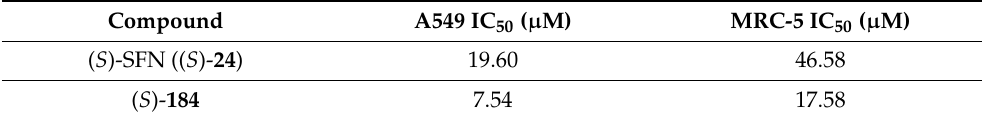
Table 6. Selectively of ( S )-SFN and ( S )- 184